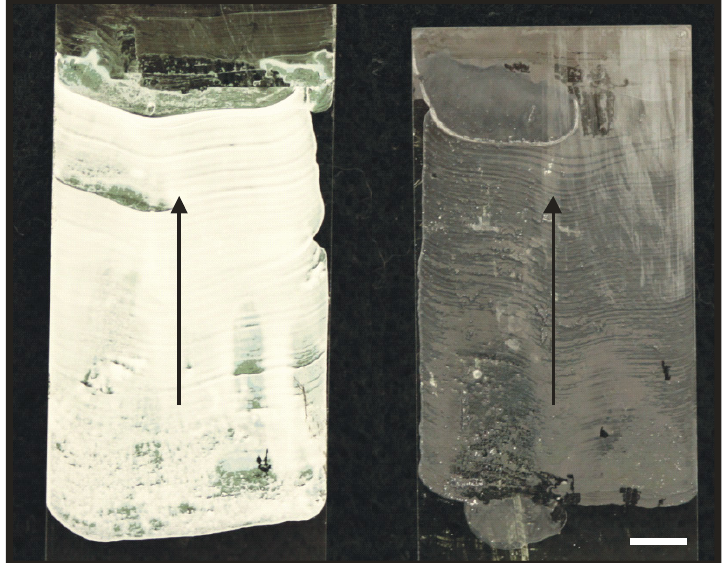
Figure 2. Coatings deposited from 1.0 µm microspheres ( left ) and an 80% (v/v) composite blend of OptiPrep TM and 1.0 µm microspheres ( right ). Scale bar is 5 mm; arrows indicate direction of